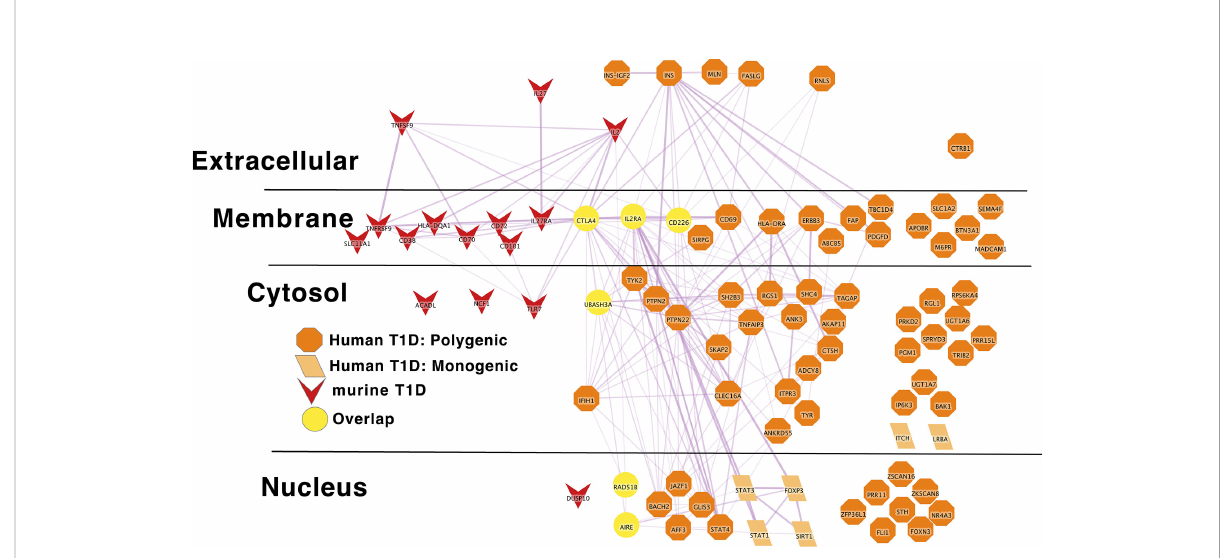
FIGURE 5 Murine autoimmune diabetes risk genes connect to Polygenic Human T1D risk genes at the periphery of the core network in a manner similar to the monogenic risk T1D network dark red inverted triangle – murine autoimmune type 1 diabetes gene; light orange parallelogram – human monogenic autoimmune type 1 diabetes gene; dark orange octagon – human polygenic autoimmune type 1 diabetes gene. Downloadable/ Interactive network diagram can be found at: